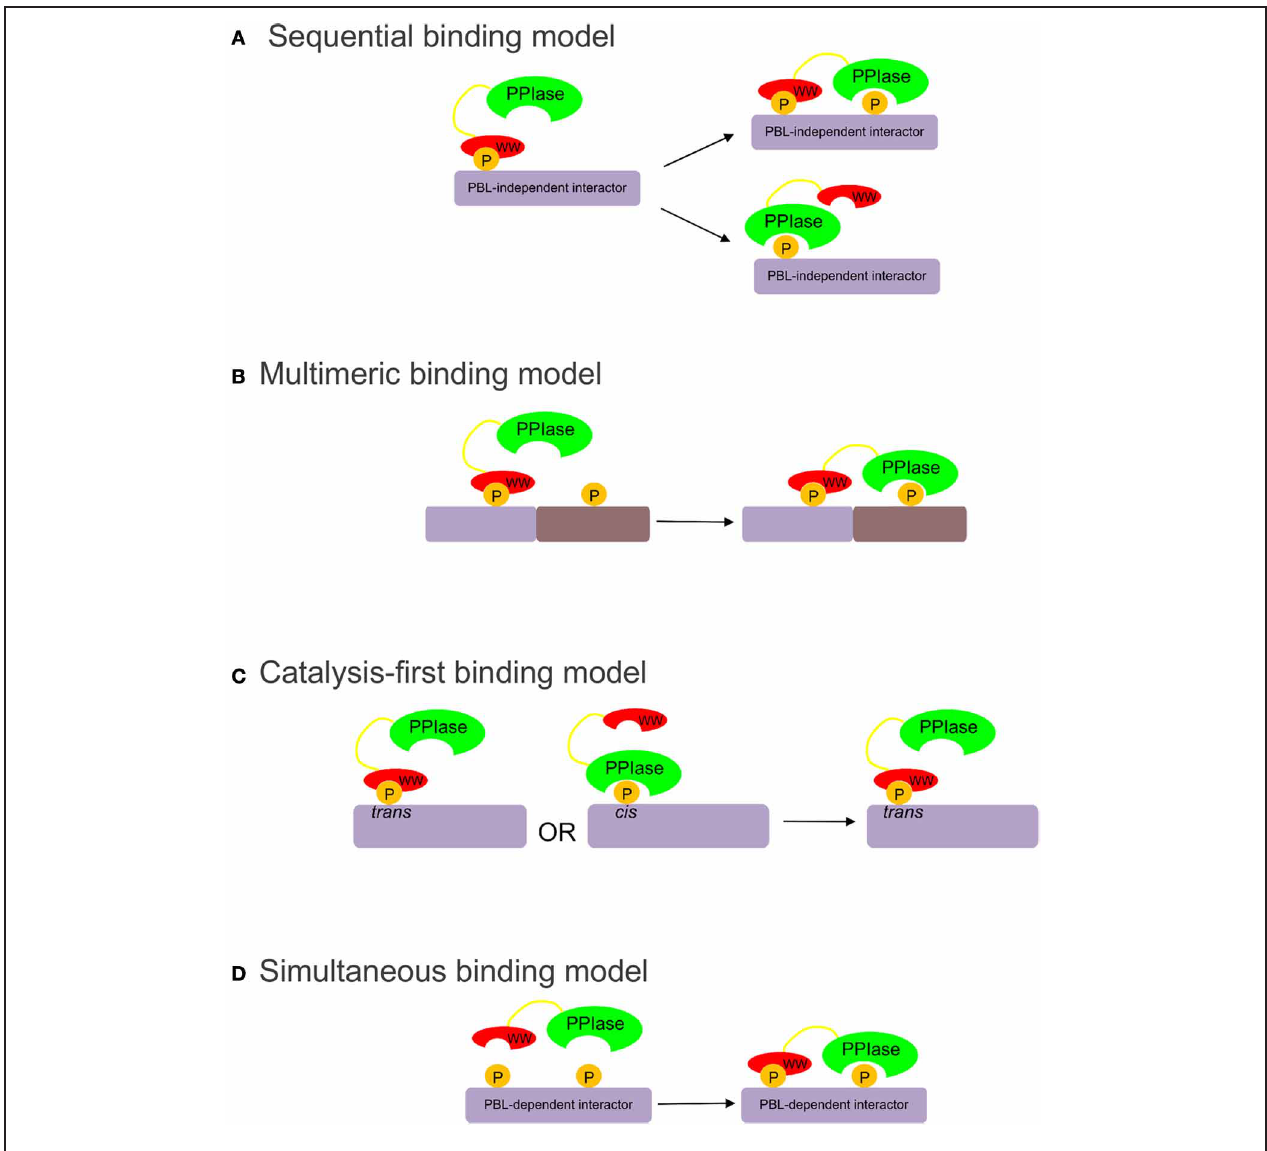
FIGURE 1 | (A) The sequential binding model proposes that the WW domain binds first, bringing the PPIase domain proximal to its targets (Zhou et al., 1999; Lu et al., 2002). (B) The multimeric binding model proposes that the WW domain anchors Pin1 in multimeric complexes, allowing the PPIase domain to target other substrates in the complex (Jacobs et al.,